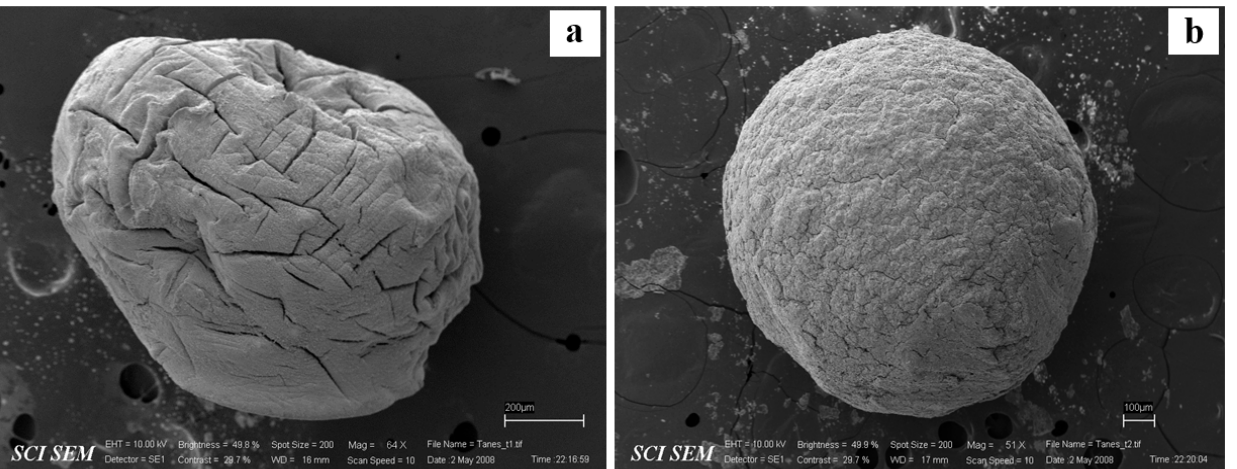
Figure 5. Particle morphology of PPN-loaded CA gel bead ( a ) and PPN-loaded CA-QPM gel bead at the SA:QPM ratios of 1:2 ( b ). the SA:QPM ratios of 1:2 ( b